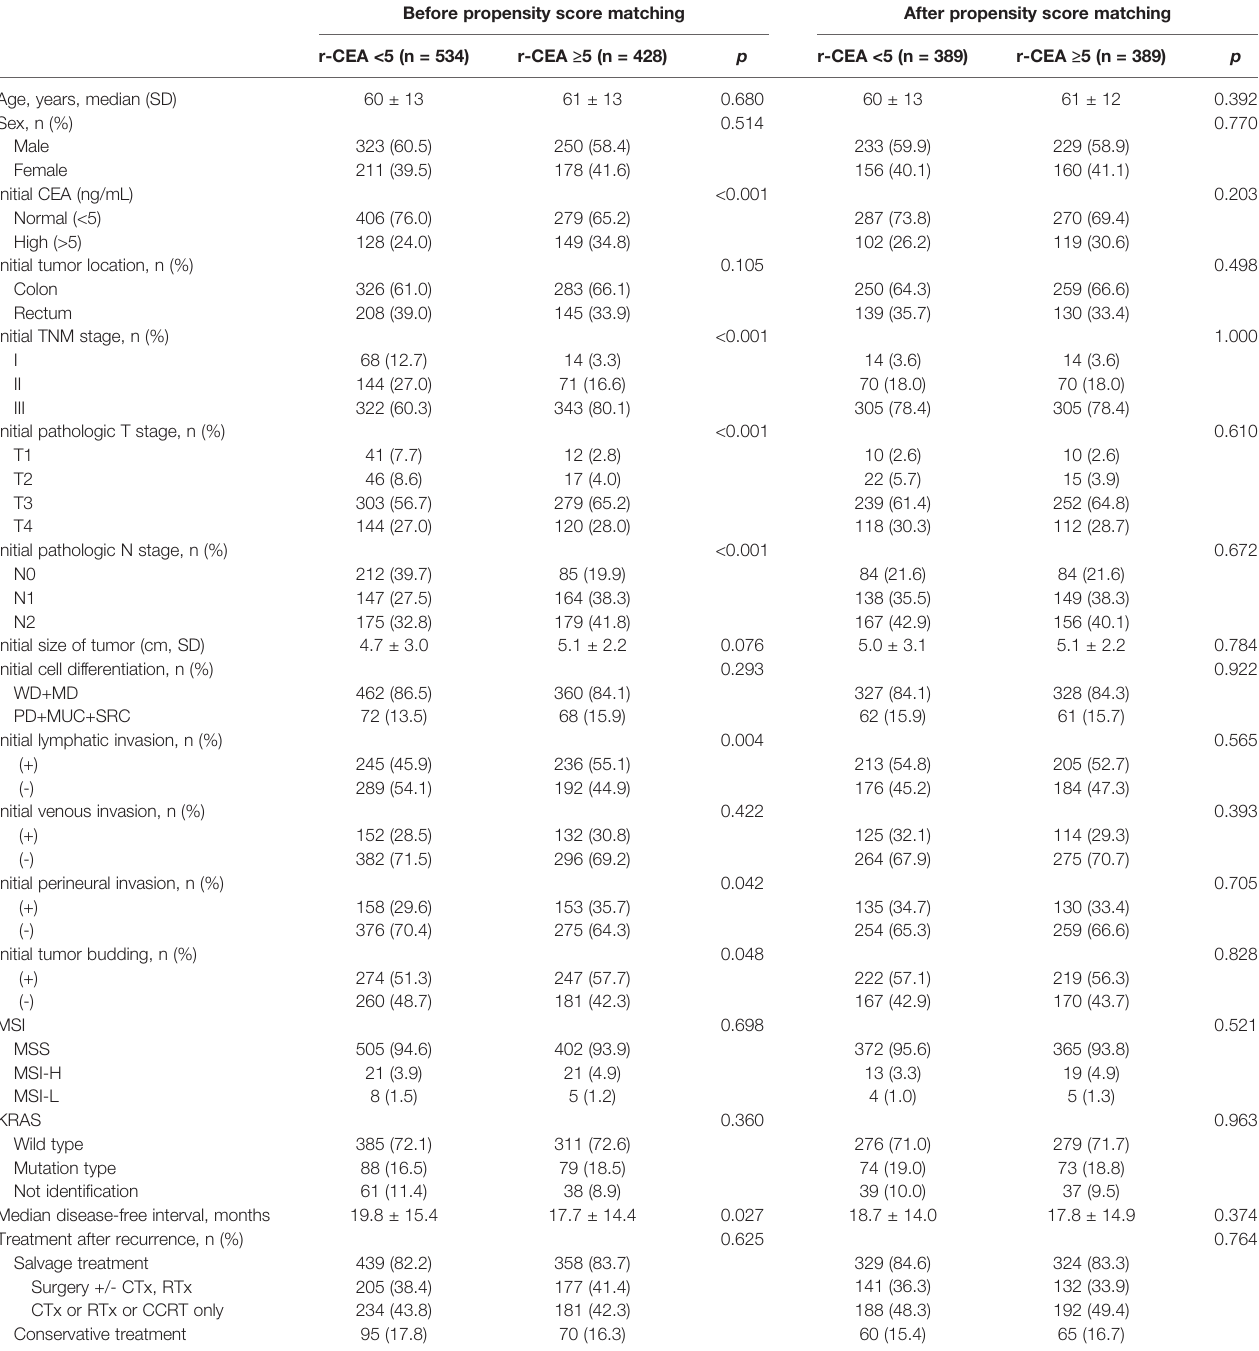
TABLE 1 | Patient clinicopathologic characteristics before and after propensity score matching